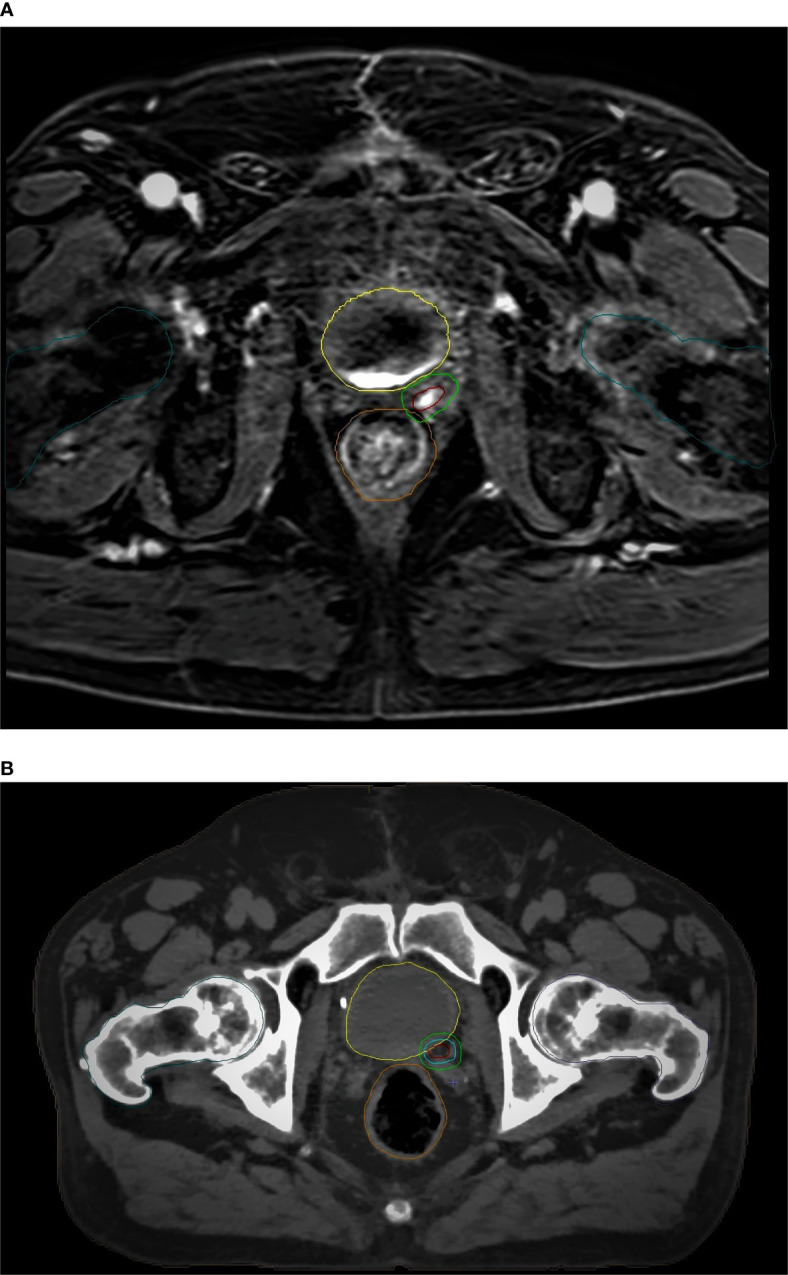
mpMRI-based (A)
vs CT-based (B) GTV/PTV (boost) and OARs delineation: brown, GTV; light green, PTV (boost); yellow, bladder; orange, rectum; dark green, femoral heads.